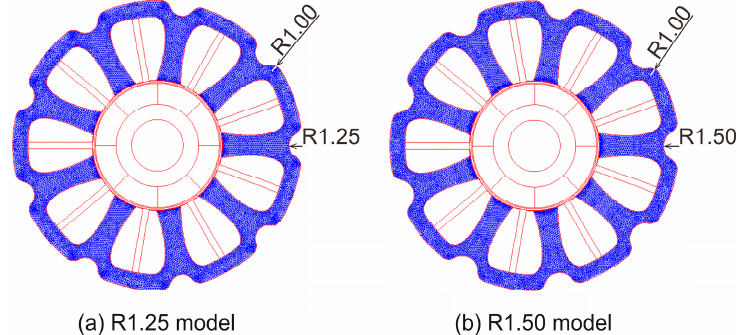
Figure 11. ( a ) R1.25 model and ( b ) R1.50 model, which are the Bezier model with the back yoke cut out by arcs with radiuses of 1.25 mm and 1.50 mm, respectively.